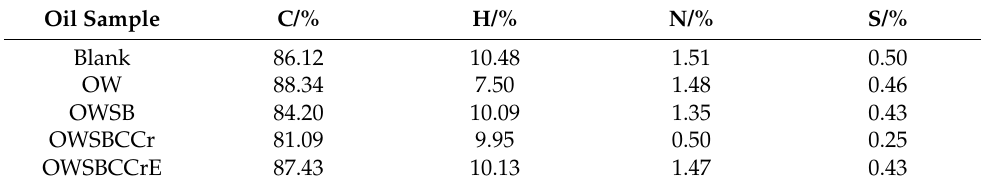
Table 4. The elemental content of heavy oil that has reacted under different conditions.